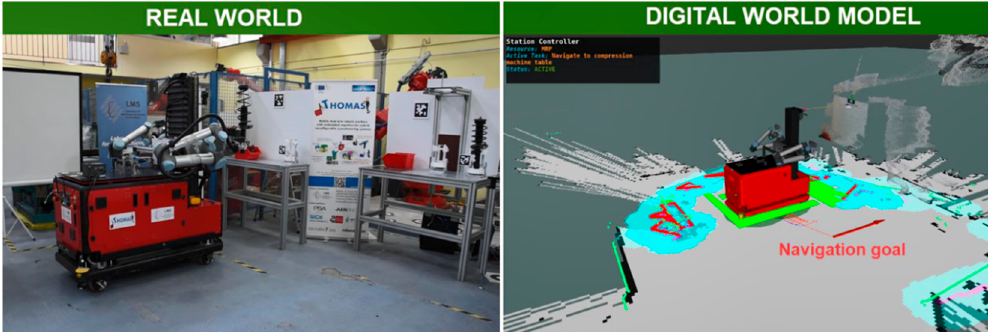
Figure 5. Autonomous navigation .